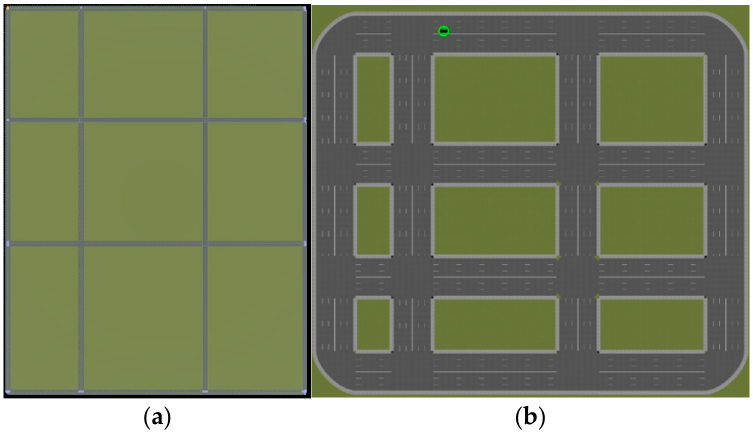
Figure 9. The road network and the corresponding driving scene. ( a ) The road network constructed by RoadRunner. ( b ) The driving scene created using SCANeR studio. Table 2. Road network parameter settings.